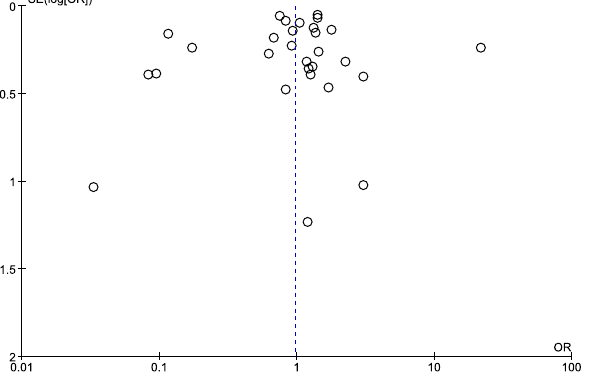
Figure 8. The funnel plot demonstrated the distribution of prevalence odds ratio of Plasmodium spp. and hookworm co-infection (ES) and standard error (SE) of the ES. ES prevalence estimate, SE standard